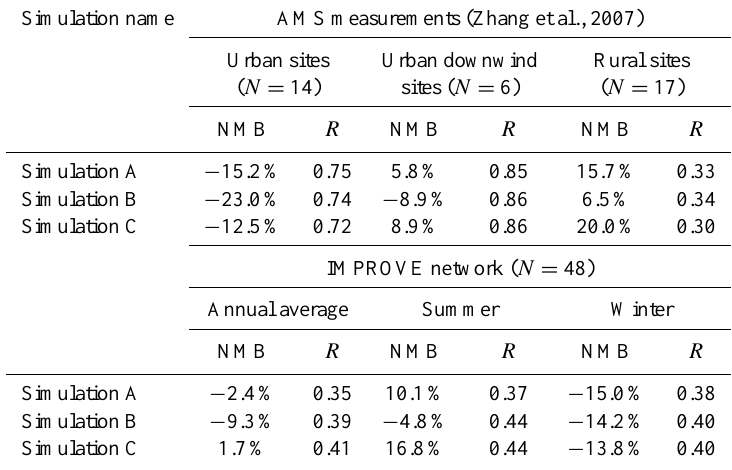
Fig. 4. Total annual averaged organic aerosol model comparison with the IMPROVE (a) and EMEP (b) observation networks. The solid lines represent ideal agreement (1:1 ratio), and the dashed lines are the 2:1 and 1:2 ratios, i.e., indicating agreement within a factor of 2. The IMPROVE network data are from 1996 to 1999, and the EMEP measurements were made in 2002–2003. The meteorology data used to run the model were for 1997. Table 7. Normalized mean bias (NMB) and correlation coefficient ( R ) between the predicted SOA for the simulation and observations. The number of sites in the comparison is in